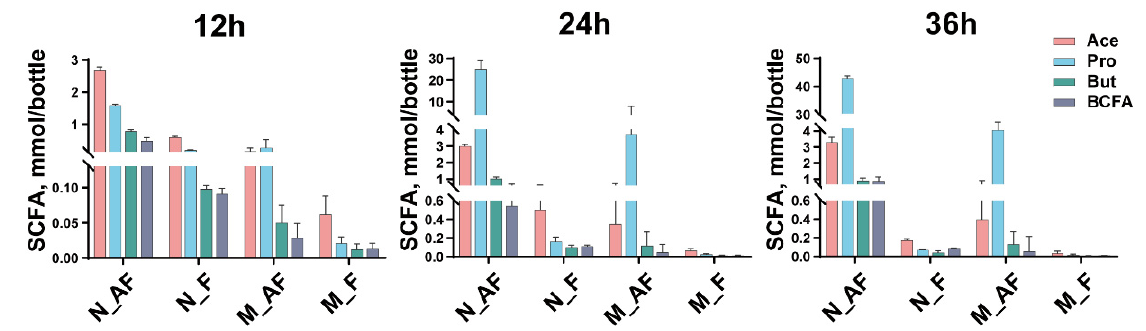
Figure 4. The amount of SCFAs in the fermentation broth for control (without substrate) among different treatments at each sampling time during fermentation.